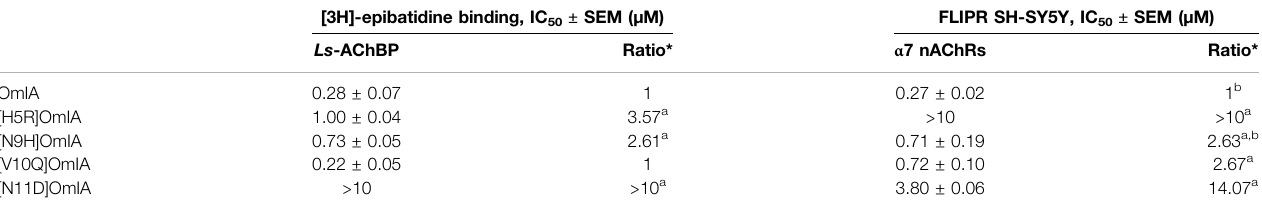
TABLE 1 | IC 50 values for displacement of ( 3 H)-epibatidine binding on Ls -AChBPs and the inhibition of choline activation at α 7 nAChR in SH-SY5Y cells in the presence of PNU120596byOmIAanditsanalogues.*RatioswerecalculatedbetweenOmIAanditsanalogues.Datarepresentmean ± SEMoftriplicatedatafromthreeindependent experiments. a denotes signi fi cant difference in IC 50 values to wildtype OmIA ( p < 0.05). b denotes 95% CIs for curve bottom values non-overlapping